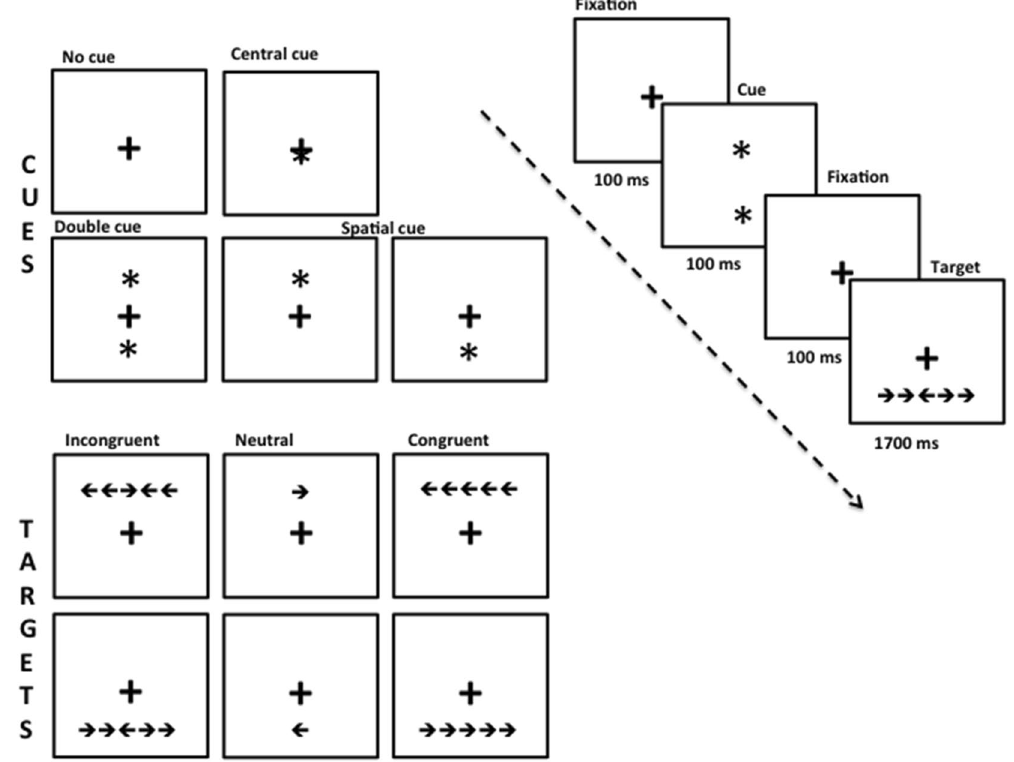
Figure 2. Attention network test (ANT); cues: no cue, central cue, double cue and spatial cues; and targets: Incongruent, neutral and congruent and an example of the procedure of ANT. Left column: sequence of events per trial of the ANT; right column: possible stimuli associated with each event. Except for the spatial and invalid spatial cue (80% vs. 20% probability, respectively), all cue and flanker constellations were equally probable and appeared up or down of the fixation cross. The target and flanker remained visible on the screen until the patients respond, but for no longer than 1700 ms. While trial duration was fixed to 4000 ms, a temporal jitter was introduced by a variable delay of the cue onset (200, 300, and 400 ms after trial onset) to reduce